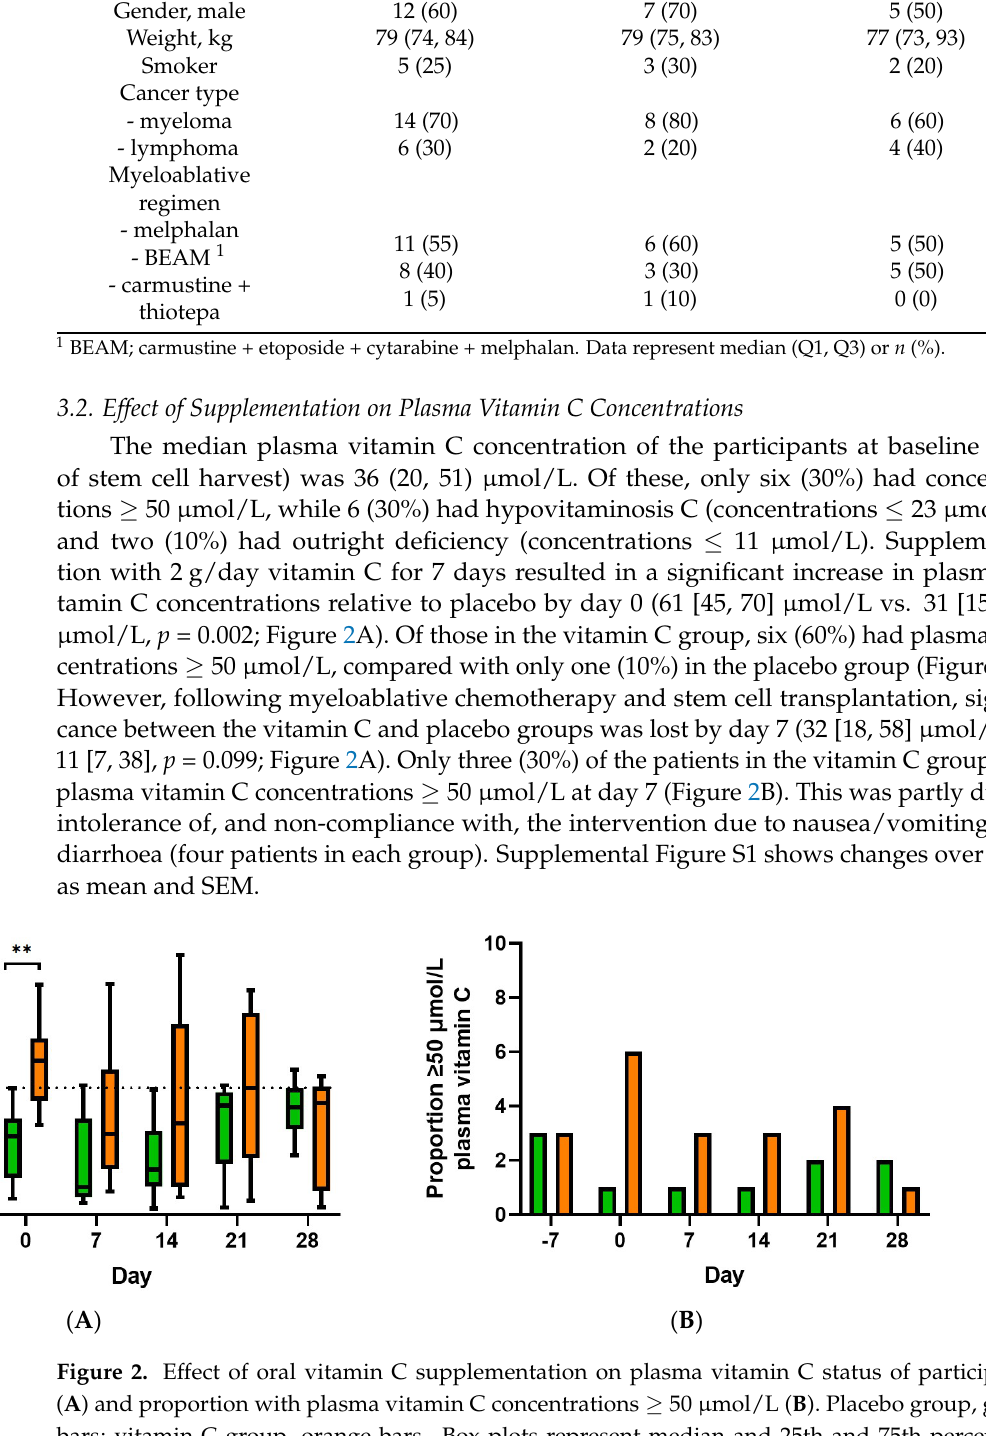
( C ) Figure 3. Infection parameters in the vitamin C and placebo groups. White cell counts ( A ), temper- ature ( B ) and C-reactive protein concentrations ( C ). Placebo group, green circles; vitamin C group, orange squares. 3.4. Gastrointestinal Symptoms By day 7, the participants were experiencing gastrointestinal disturbances, including appetite loss, nausea/vomiting and diarrhoea, as determined by the EORTC QLQ (and confirmed by CTCAE adverse event monitoring; Figure 4). Eight participants (40%) expe- rienced oral mucositis at days 7 or 14, four in the placebo group and four in the vitamin C group. All four participants in the vitamin C group had grade 1 oral mucositis, while two of the four participants in the placebo group had grade 1 oral mucositis and the other two had grade 2 oral mucositis.